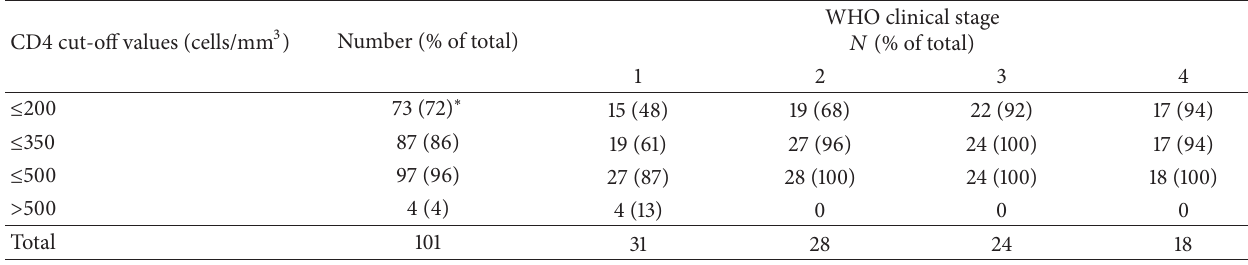
Table 1: Frequency distribution of the various CD4 cut-off values and corresponding WHO clinical stage for the initiation of antiretroviral therapy ( 𝑛 = 101 ).